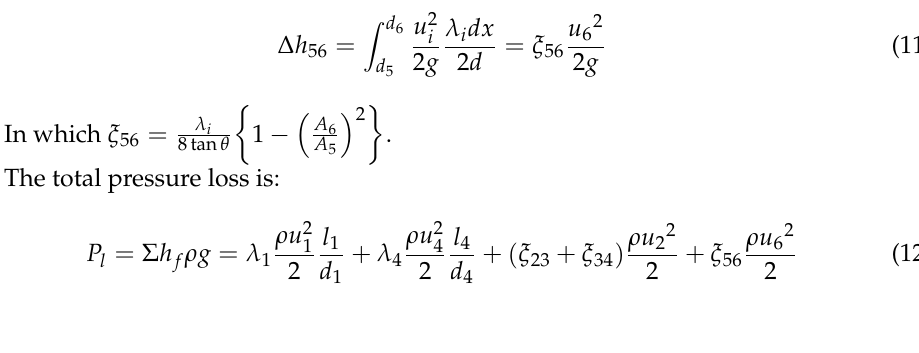
L 2 ' Figure 8. The expansion of the nozzle and flapper.